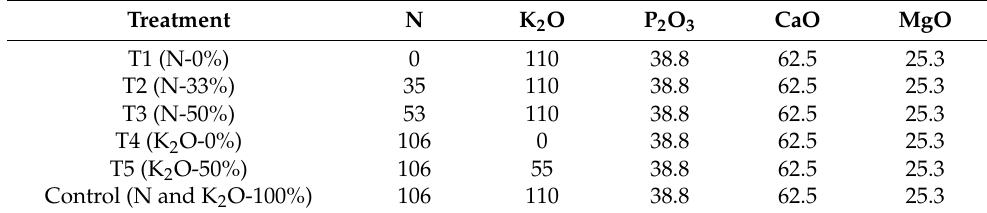
Table 1. Fertiliser doses (kg/ha) for each